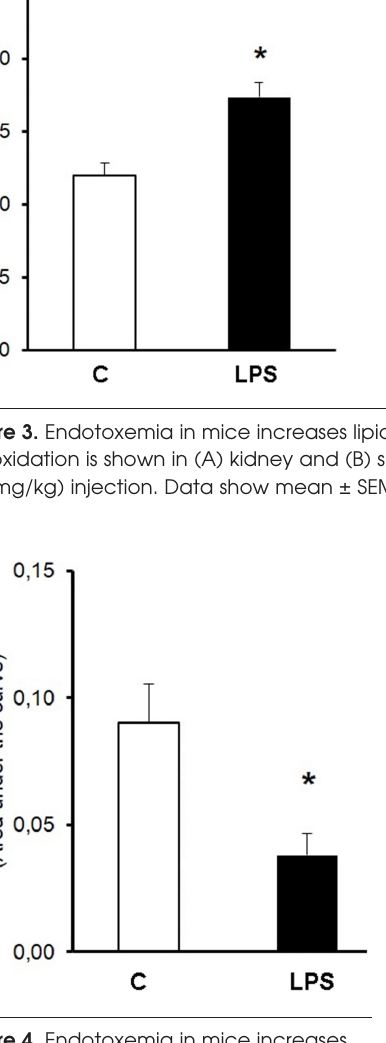
Figure 4. Endotoxemia in mice increases tissue antioxidant activity. Antioxidant ac- tivity is shown in erythrocyte samples from mice 1 h after LPS (15 mg/kg) injection. Data show mean ± SEM of 6–8 animals per group. * p < .05.